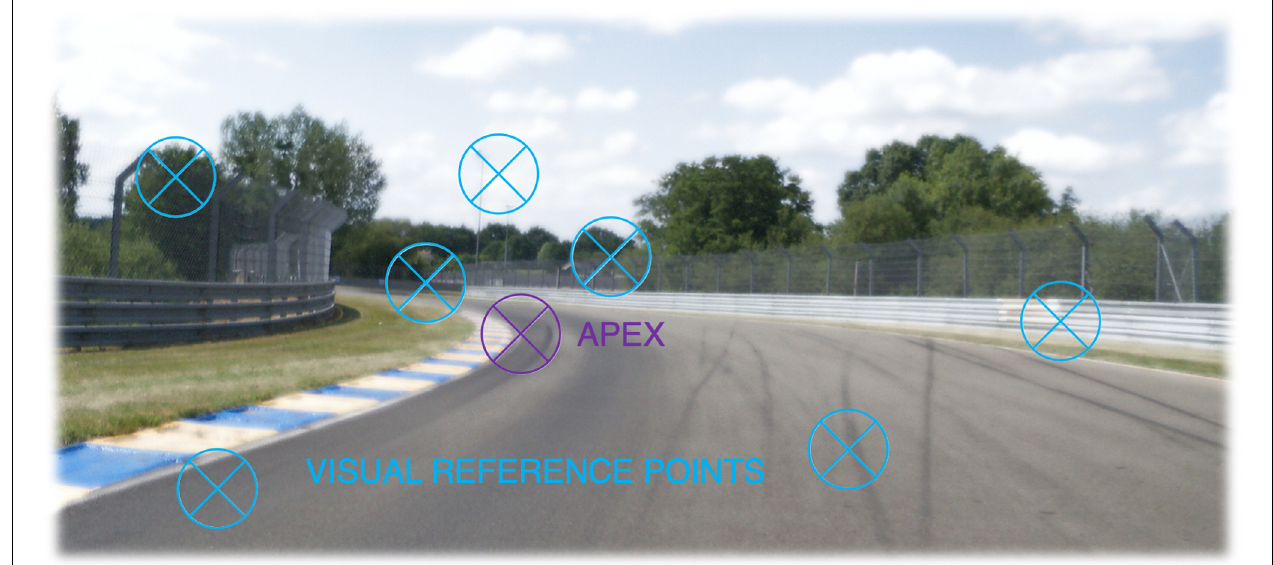
FIGURE 3 | A racing driver will drive a familiar track on the basis of visual references. Fixing locations in memory and recognizing them by landmark features allows expert drivers to remain oriented, and drive at high speed even when available preview distance is limited. Where the references are will depend on the prior experience and individual preference of the driver [Note that cognitive modeling in other domains have estimated that the number of items in memory that would be needed to support expert performance would be on the order of tens or hundreds of thousands of stored relational patterns (chunks). As discussed in the main text, 10–100 reference points for 10–20 corners on a hundred racetracks would give the same order of